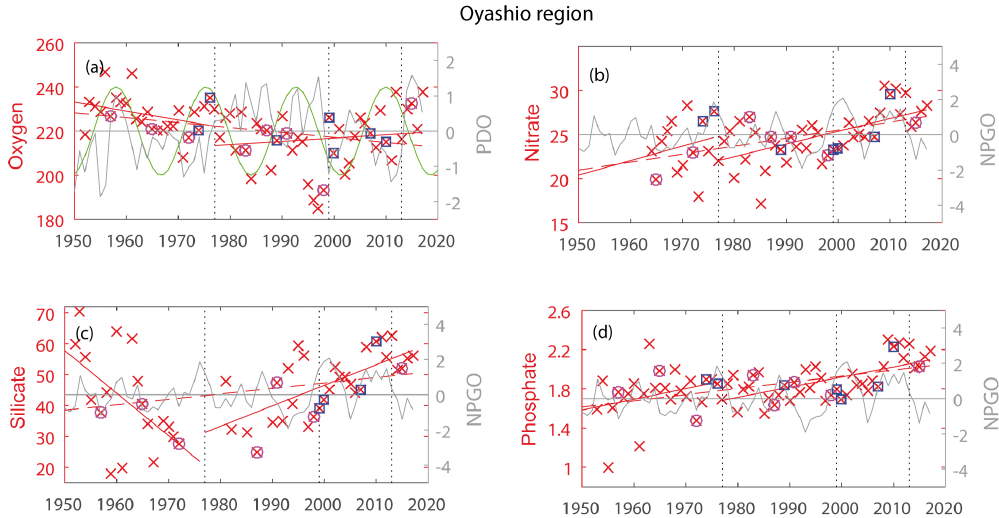
Figure 7. Annual mean concentration (µmolkg − 1 , red crosses) for years available and trends for the layer 50 to 300m plotted for the periods 1950 to 1976 for the negative PDO phase and after 1976 for the positive PDO phase (solid red lines) and for the entire time period (dashed red lines) for the Oyashio region (39–42 ◦ N, 144–149 ◦ E) from hydrodata CTD and bottle data and a data collection used in Whitney et al. (2013) and Sasano et al. (2018) in micromoles per kilogram per year for (a) oxygen, (b) nitrate, (c) silicate and (d) phosphate. For nitrate, measurements in 1963 were removed as the 50–300m mean was much too high (1.27µmolkg − 1 ). El Niño years defined as strong are marked by an additional magenta circle and strong La Niña years by an additional blue square. The changes of the PDO status in 1977, 1999 and 2013 are marked by vertical dotted lines. In the oxygen time series the 18.6-year sinusoidal nodal cycle is included (green curve). The annual mean PDO index is shown in the oxygen time series as a grey curve, and the annual mean NPGO index is shown in the nitrate, silicate and phosphate time series as a grey curve. Table 2. Correlation coefficient and p value for available data since 1950 between annual layer from 50 to 300m concentration and PDO and NPGO with PDO–NPGO lags (negative PDO–NPGO leads). Areas with large p values>0.05 are considered not significantly correlated. Area Parameter PDO lag PDO correlation ( p ) NPGO lag NPGO correlation ( p ) oxygen − 7